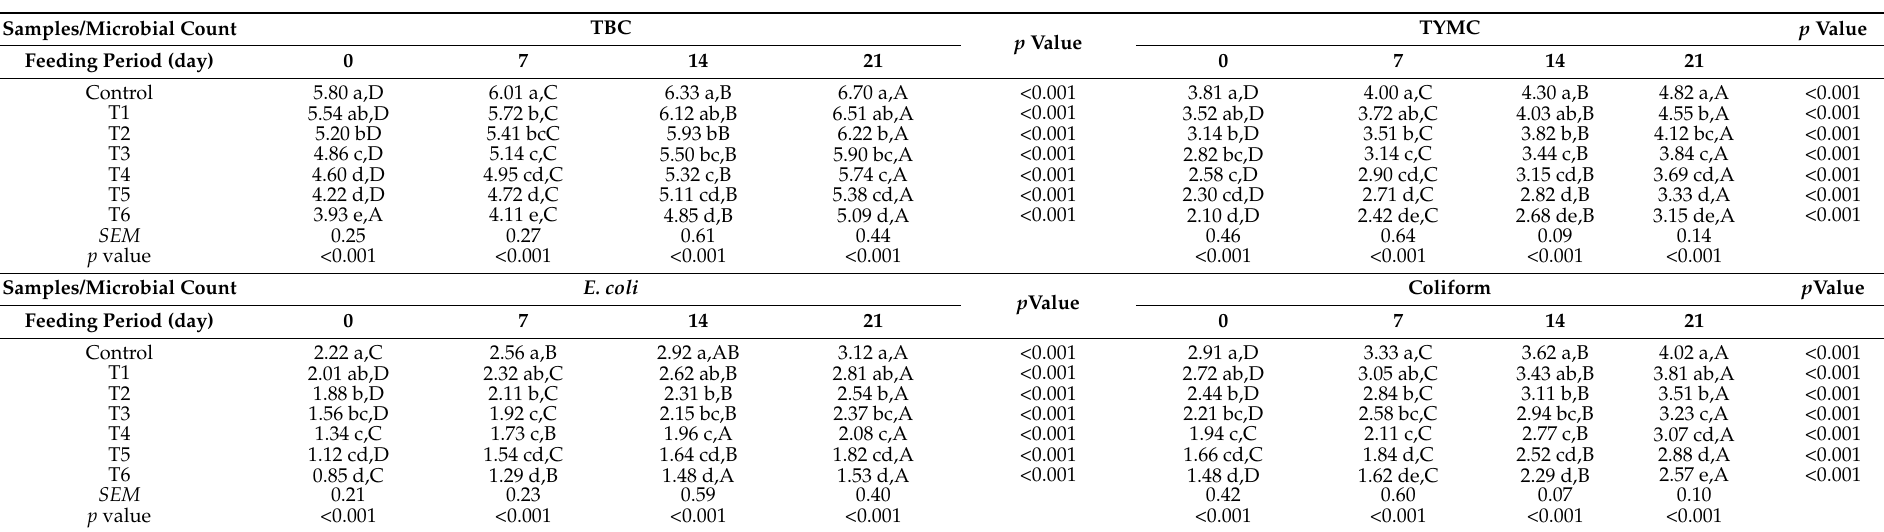
TYMC p Value p Value